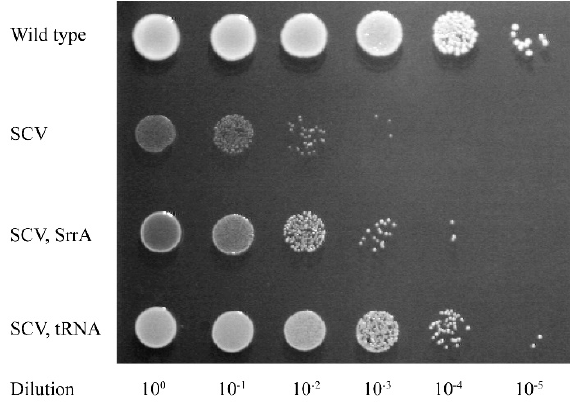
FIGURE 2: Spot test assay showing relative fitness differences be- tween wild-type, SCV, and suppressed mutants . For each strain 10 colonies from an LB agar plate incubated at 37°C for 24 hours were suspended in 1 mL 0.9% NaCl. Each spot represents 5 µL of cell sus- pension pipetted onto LB agar, with 10-fold dilutions as indicated, incubated at 37°C for 24 hours before photography. The SCV mu- tation is menB D151N, and the suppressed mutants shown are iso- genic strains carrying suppressor mutations in srrA and tRNA-Asp,